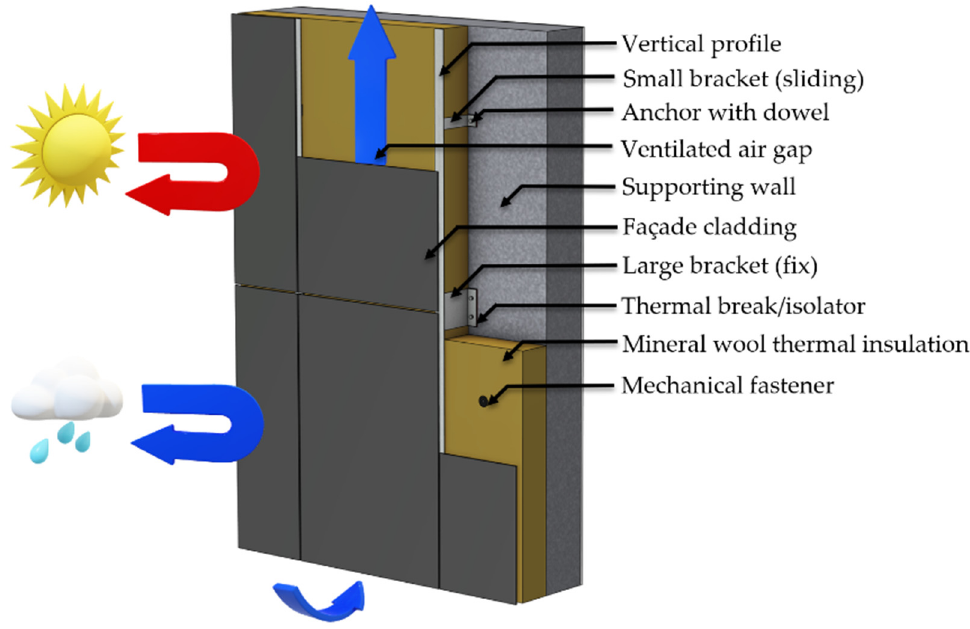
Figure 1. Structure of a ventilated façade cladding acting as a parasol-umbrella.